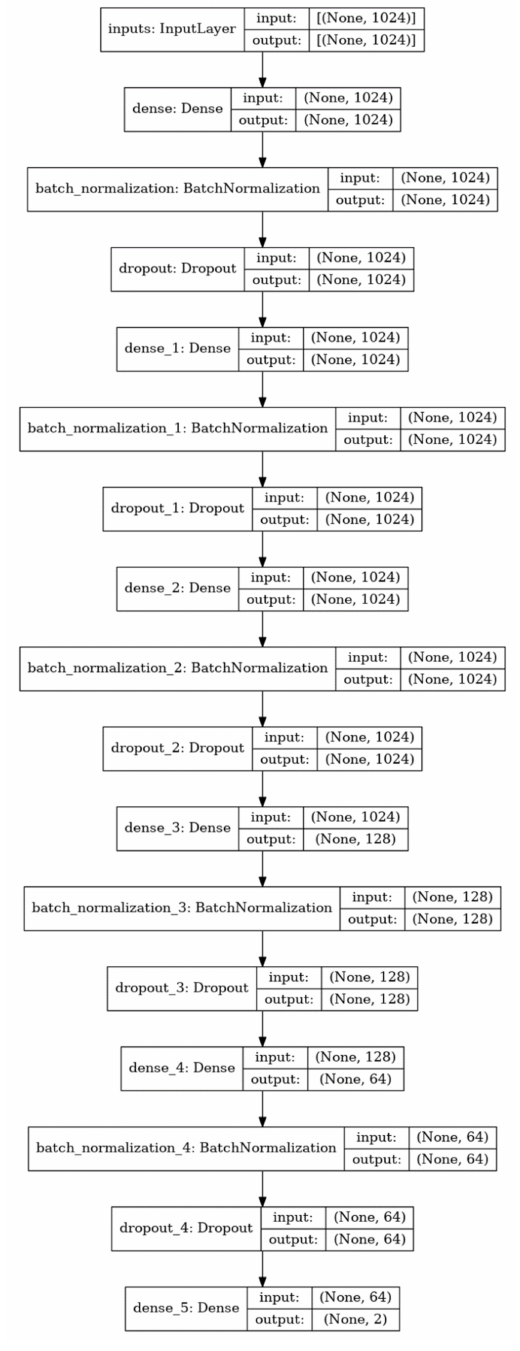
Figure 4. The deep neural network architecture of the DILI prediction